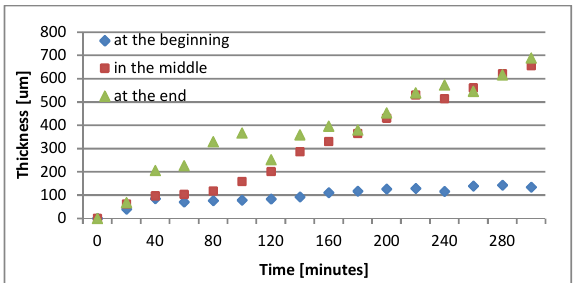
Fig. 9. Comparison of fouling layer thickness at different locations along a hollow fiber membrane vs time (15 cm fiber length, CFV 33 mm/s).